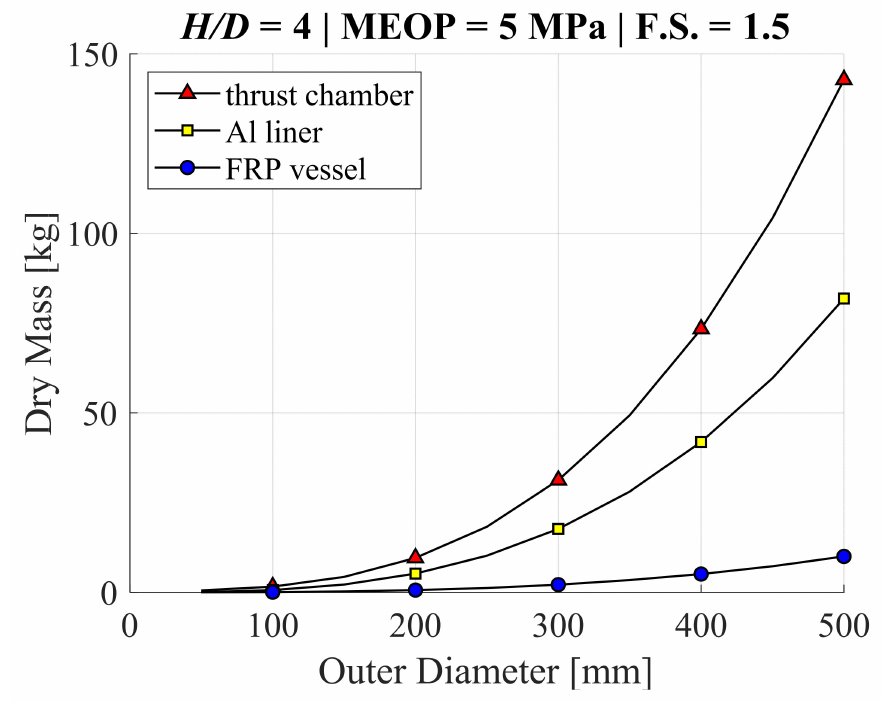
Figure 7. The thrust chamber is significantly more massive than the pressure